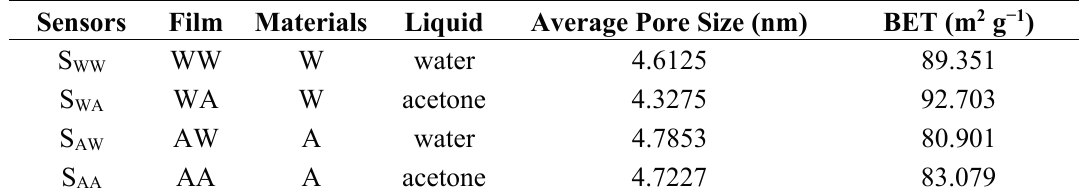
Table 1. Average pore size and BET surface area of four-type